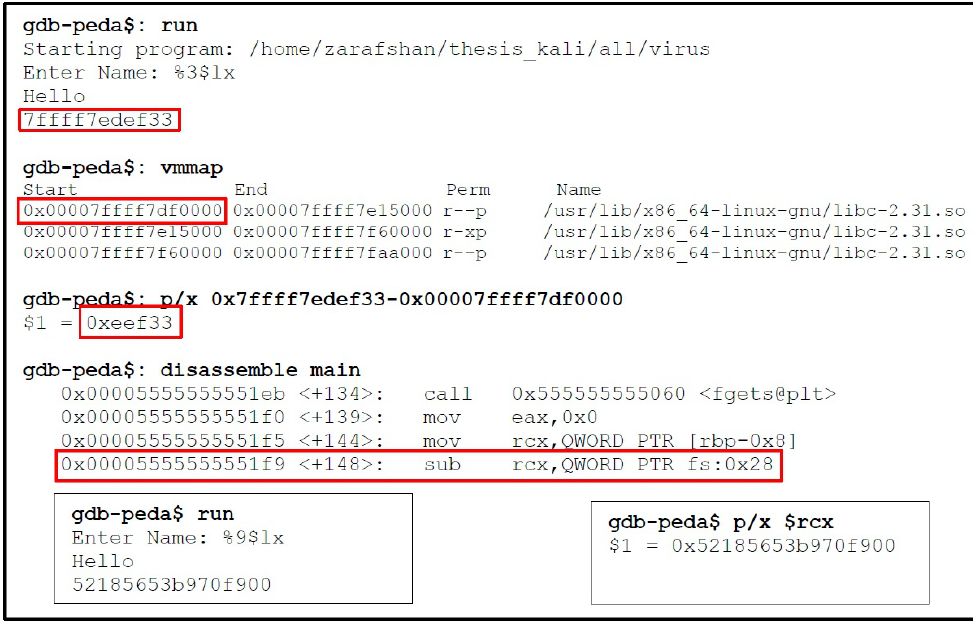
Figure 33. Checking libc Address and Stack